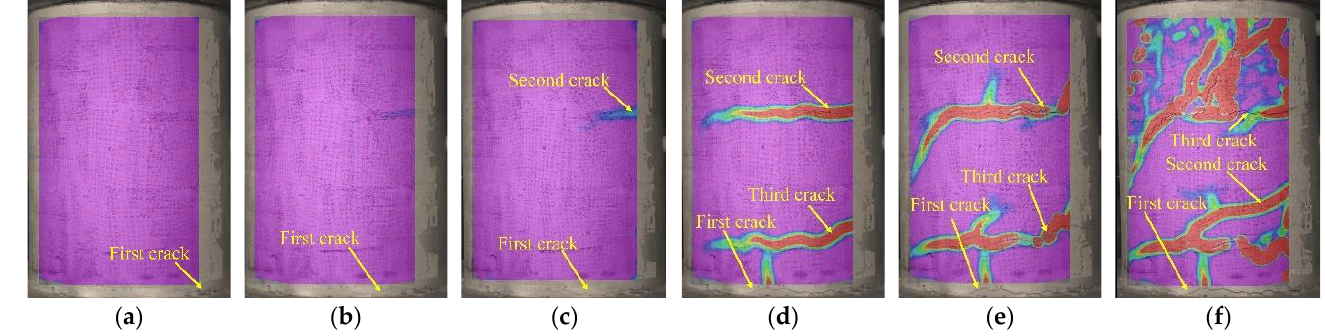
Figure 19. Principal strain nephograms of test specimen G1. ( a ) 24 kN; ( b ) 36 kN; ( c ) 51 kN; ( d ) 70 kN; ( e ) 80 kN; ( f ) 90 kN.